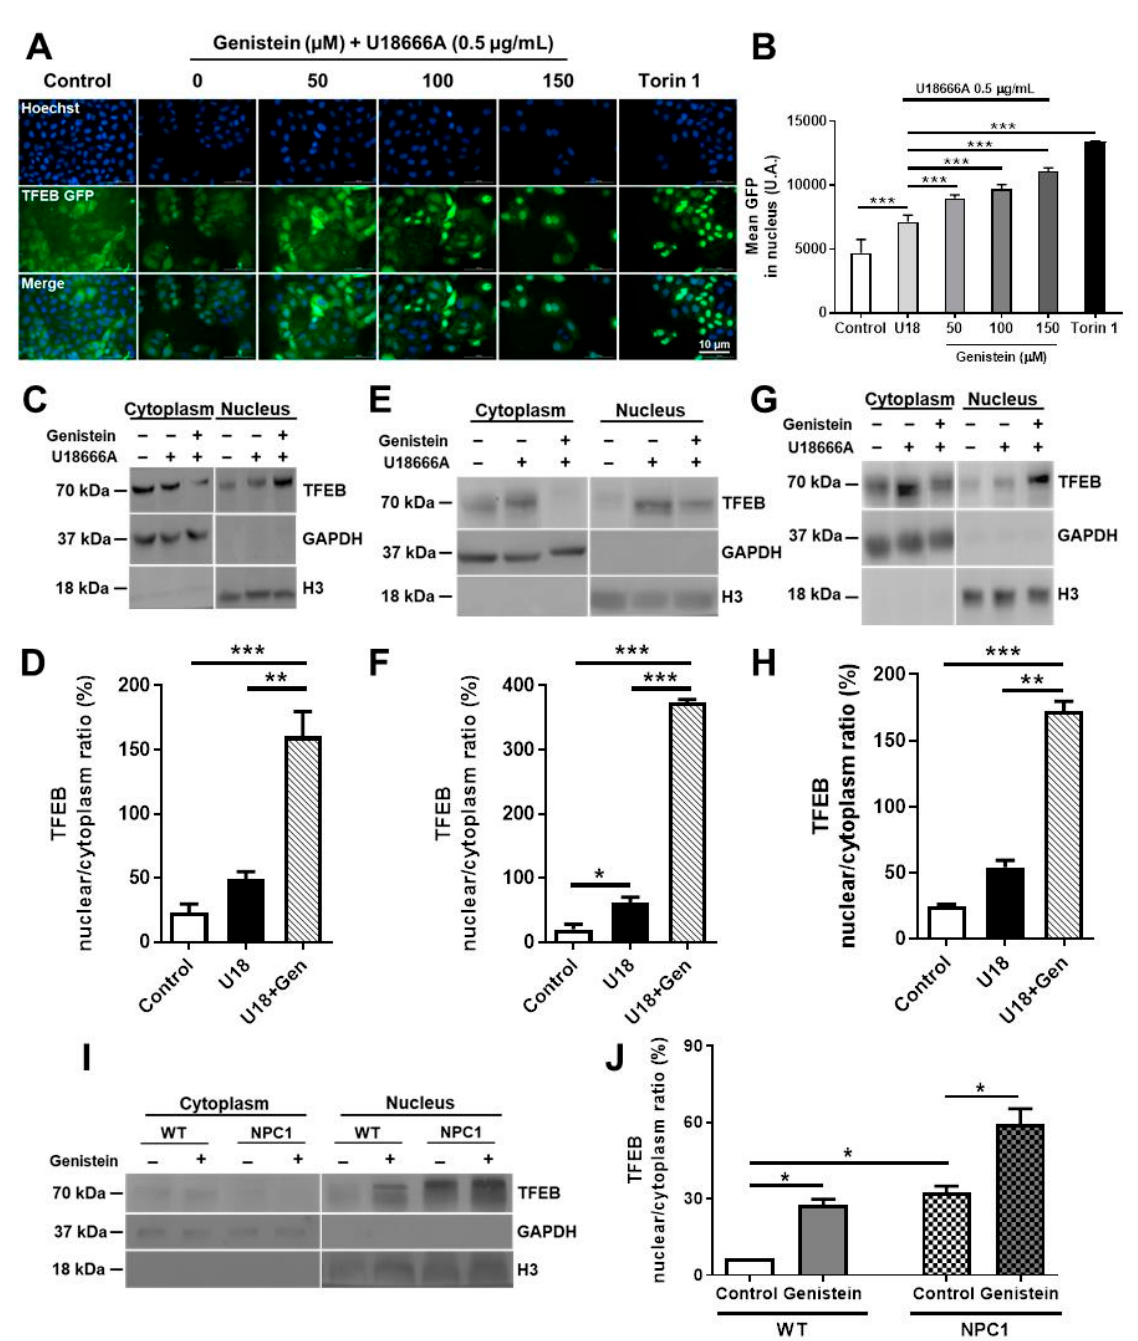
Figure 1. Genistein promotes transcription factor EB (TFEB) nuclear translocation to the nucleus in Niemann–Pick type C (NPC) cells. Representative images and quantification ( A , B ) of the TFEB-GFP translocation assay in HeLa cells stably expressing TFEB-GFP treated with 50, 100, and 150 µ M of genistein, in control conditions or treated with U18666A (U18) 0.5 µ g/mL for 24 h at the same time. As a positive control for TFEB nuclear translocation, we used 0.3 µ M Torin 1 for 3 h. TFEB-GFP nuclear localization was analyzed using a high-content nuclear translocation assay in an epifluorescence automated microscope. Scale bar: 10 µ m, GFP (green) and Hoechst (blue). For each condition, 3000–5000 cells were analyzed (five wells × 16 images). Representative immunoblot and quantification of endogenous TFEB levels in lysates from nuclear and cytoplasmatic fractions obtained after 24 h treatment with 150 µ M of genistein, in control or 0.5 µ g/mL of U18 treated HeLa cells stably expressing TFEB-GFP ( C , D ), Huh7 cells ( E , F ), SHSY-5Y cells ( G , H ), GM05659 WT, and the GM03123 NPC1 patient fibroblasts ( I , J ). Human Glyceraldehyde-3-phosphate dehydrogenase (GAPDH) and Histone H3 were used as cytoplasmatic and nuclear loading controls, respectively. * p ≤ 0.05, ** p ≤ 0.01, *** p ≤ 0.001 data represent mean ±